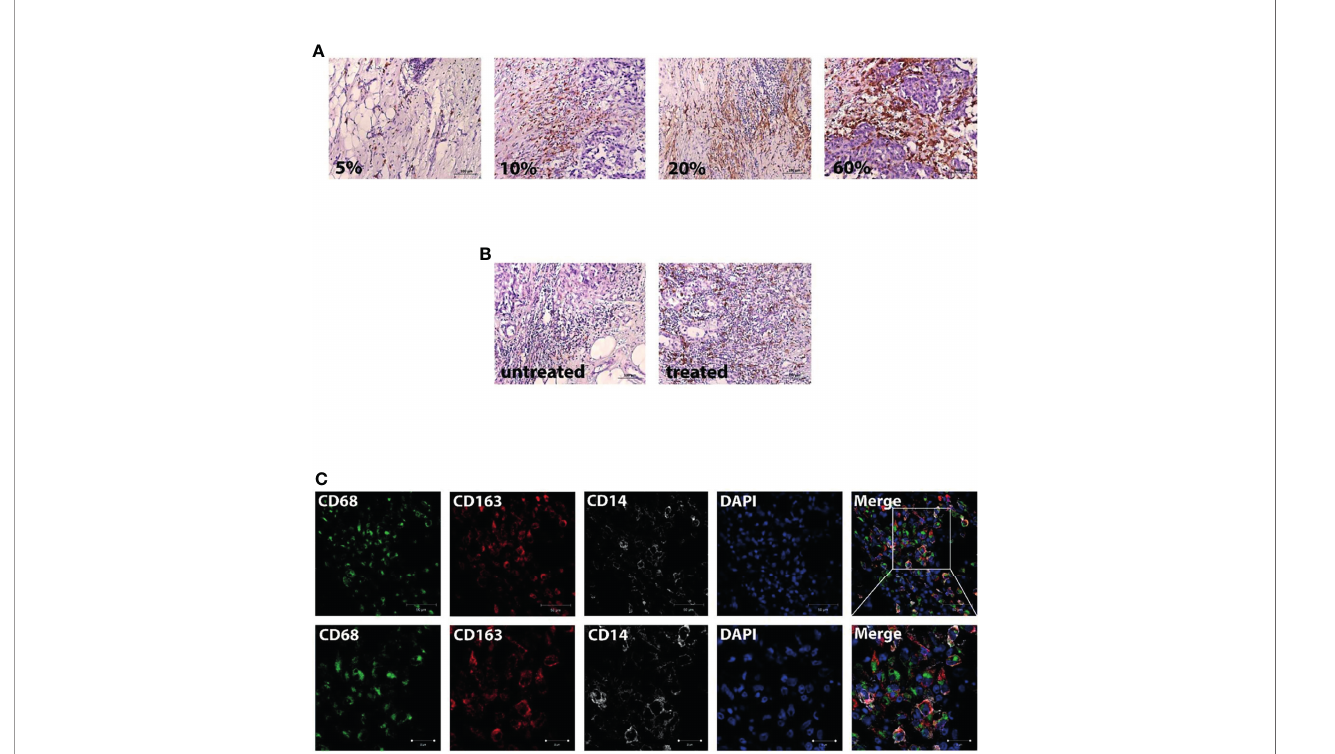
FIGURE 4 | Breast cancer tissue is in fi ltrated by CD163-positive monocyte. (A) Examples of the percent content of the stromal surface area which was occupied by CD163+ cells. Scale bars correspond to 100 µm (×200). (B) Representative images from untreated and NAC-treated breast tumor tissue. Scale bars correspond to 100 µm (×200). (C) IF/confocal microscopy analysis was performed for breast tumor tissues. The in fi ltration of CD14+CD68+CD163+ cells was found in all samples. Representative images are demonstrated. Scale bar corresponds to 50 µm in the main image and 20 µm in the zoom